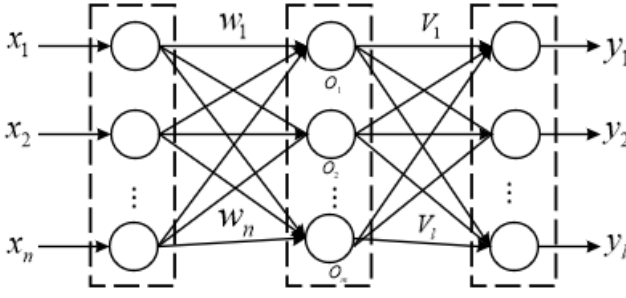
Figure 14. Typical feedforward BP neural network structure.